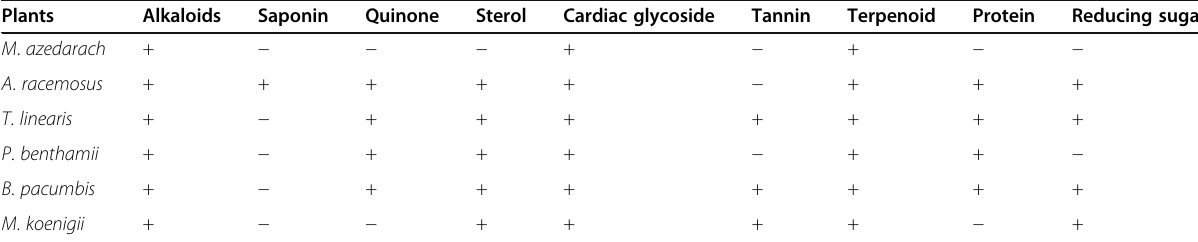
Table 2 Results on qualitative phytochemical screening Plants Alkaloids